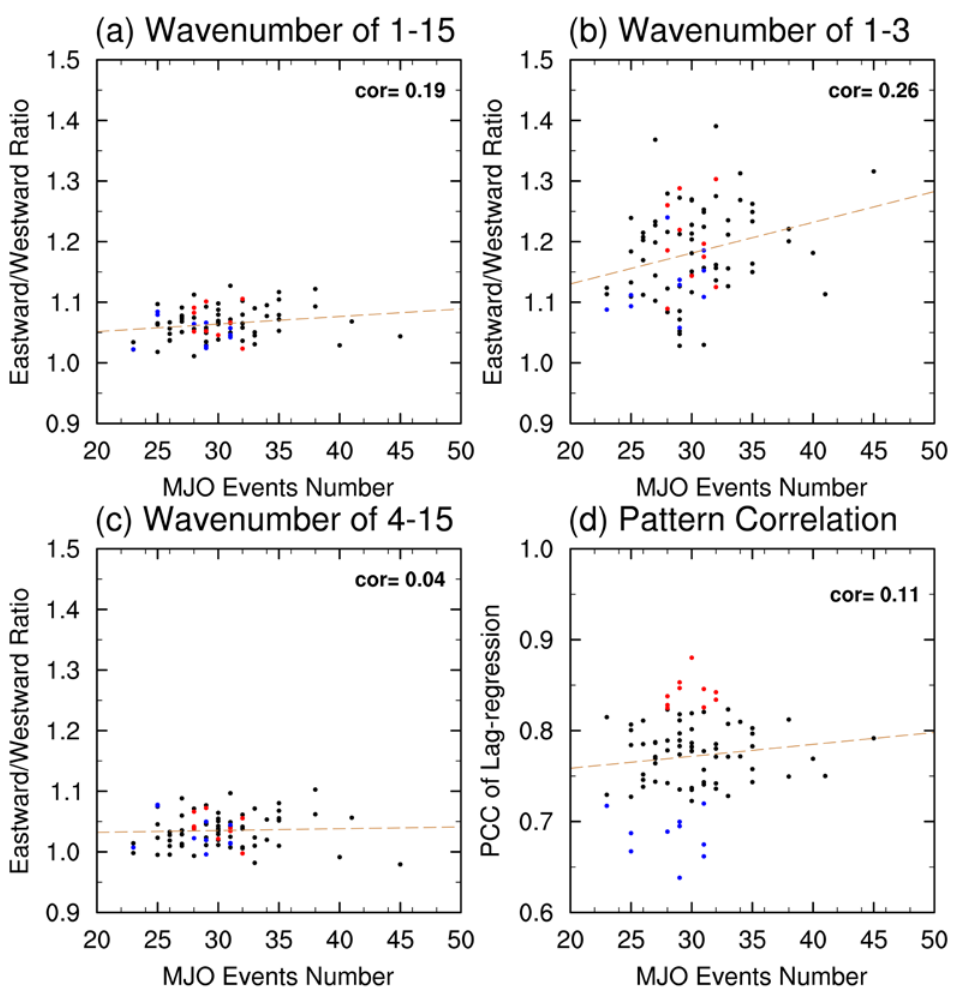
Figure 3. Same as in Figure 2 but with x axis denotes the quantity of MJO events in model integration given by MJO tracking method. y axis donates to scores by E/W ratio of wave number ( a ) 1–15, ( b ) 1–3, ( c ) 4–15 and scores by Lag-correlation in ( d ).